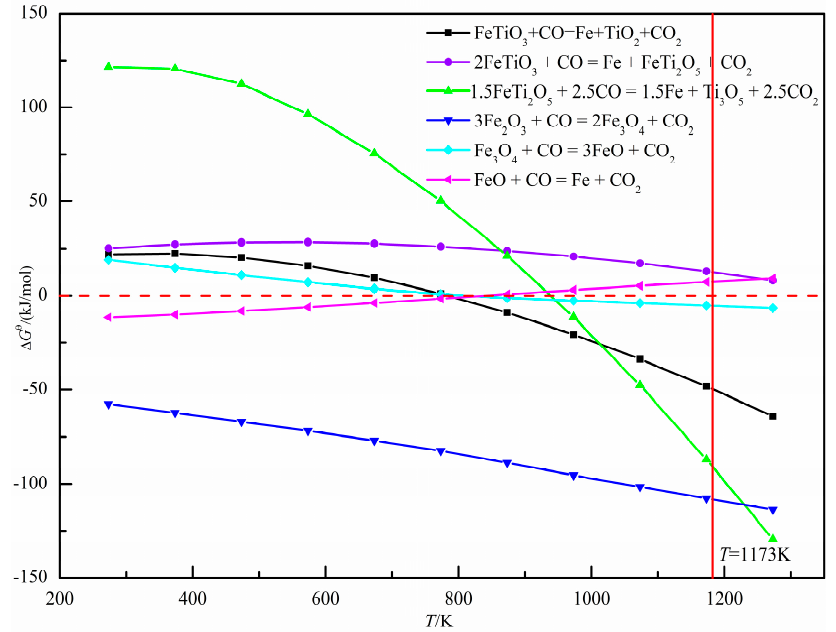
Figure 15. Relationship between Δ G θ and T in the reduction process of oxidized pellets with sea sand ore.